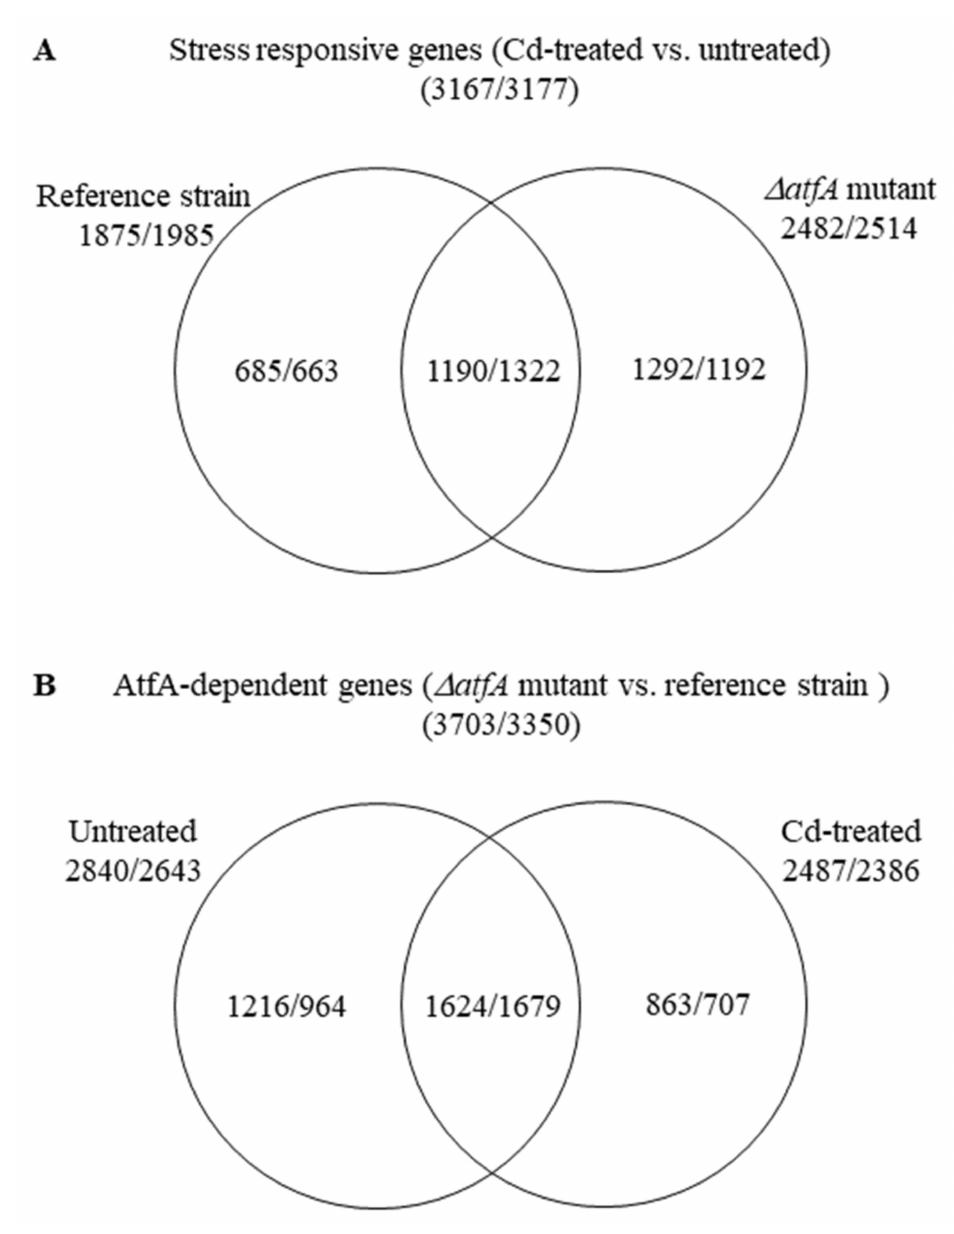
Figure 2. Distribution of stress responsive genes between the THS30 reference strain and the TNJ92 ∆ atfA mutant ( A ) as well as of the AtfA-dependent genes between the untreated and CdCl cultures ( B ). Figures represent the number of up-regulated/down-regulated genes. For definition of up-regulated, down-regulated, stress responsive, and AtfA-dependent genes. See the chapter titled “2.5 Evaluation of RNAseq